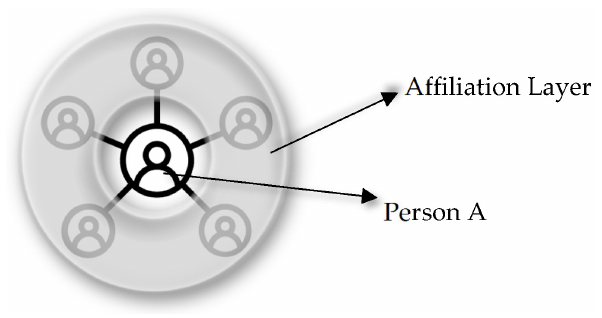
Figure 1. Family membership